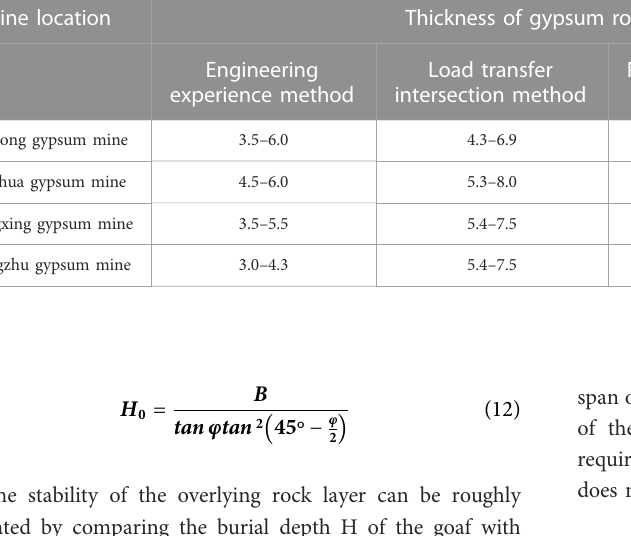
TABLE 8 Calculation table of thickness of gypsum roo fi ng layer. Mine